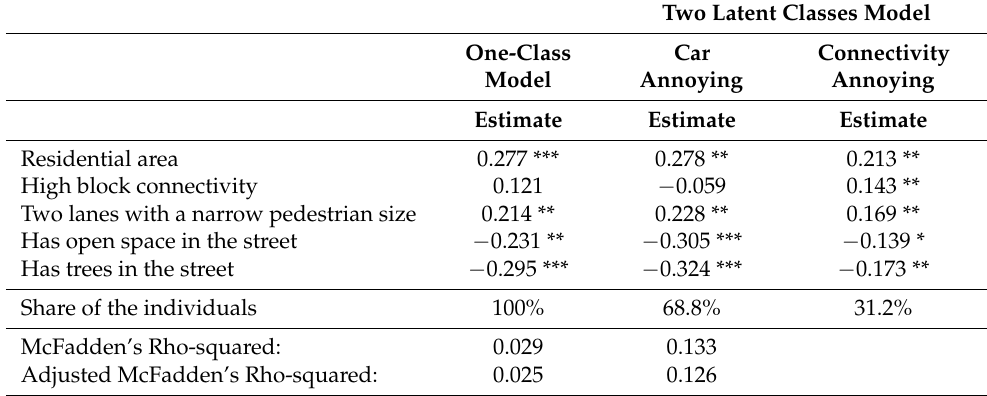
Table 10. Results for latent-class regression models ( annoyance sense ).